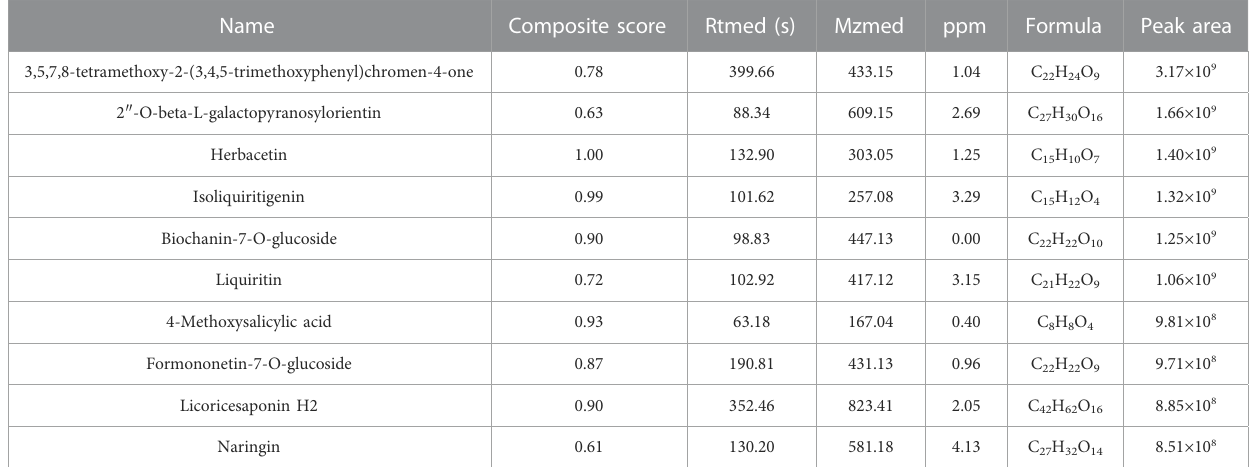
TABLE 3 Identi fi cation of components of YQYXF by UHPLC-QE-MS analysis (top